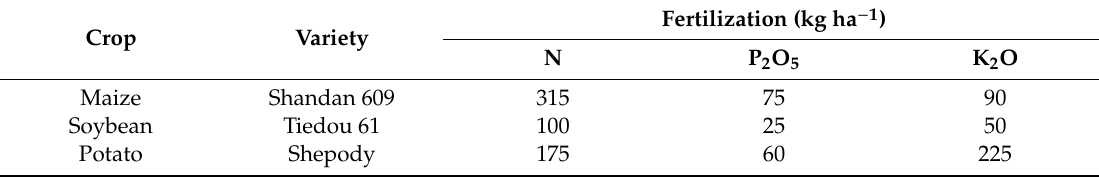
Table 1. Crop varieties and fertilization management